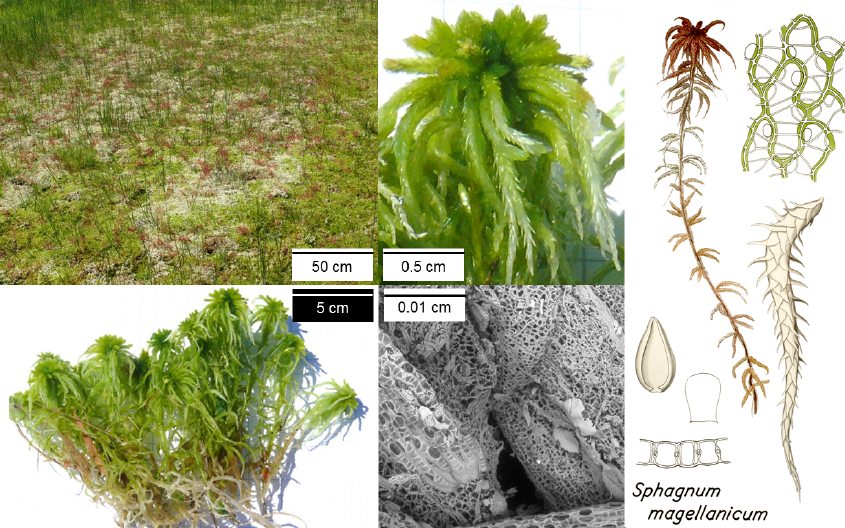
Figure 1. Sphagnum moss structures and soil pore sizes. (a) Sphagnum lawn with visible bleaching due to desiccation of the capitula (in the German language Sphagnum is also referred to as “Bleichmoos”, which translates as “bleaching moss”), (a, b) images of Sphagnum cuspidatum H. Klinggr . to exemplify the (b) sampled and slightly spread out individuals with visible inter-connectedness of branches, (c) close-up of the capitulum with pending branches and leaves, and (d) scanning electroscope microscopy image of Sphagnum leaves on a branch with visible dark circles as the opening to the hyaline cells (courtesy of Reuven Simhayov). Right panel: drawing of Sphagnum magellanicum (courtesy of Bent Johnsen. ©Department of Biology, University of Copenhagen) with (e) individual plant, (f) branch surface with skeletal structure in green, (g) branch with leaves, (h) cross section of a leaf with large hyaline cells, and (i) individual